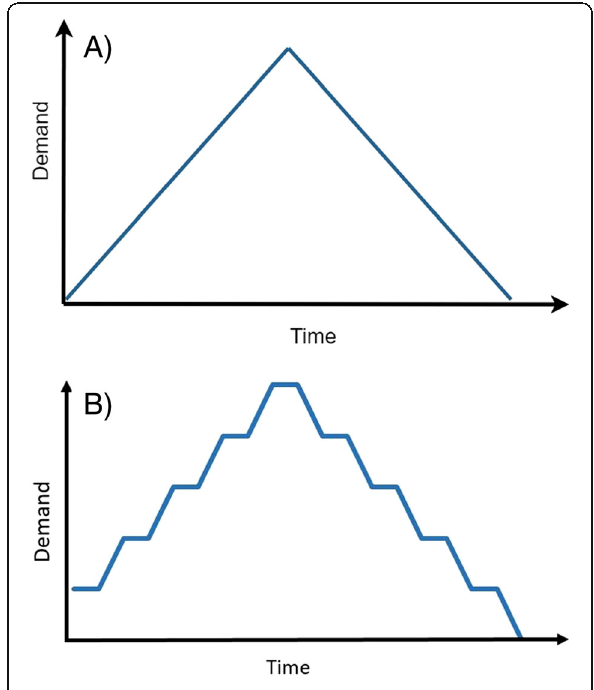
Fig. 2 Demand scenarios: a Steady rise and fall of demand; b Stepped rise and fall of